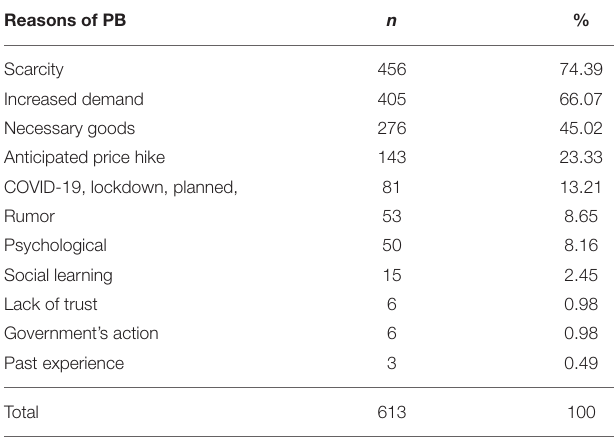
TABLE 2 | Reasons of panic buying ( n =